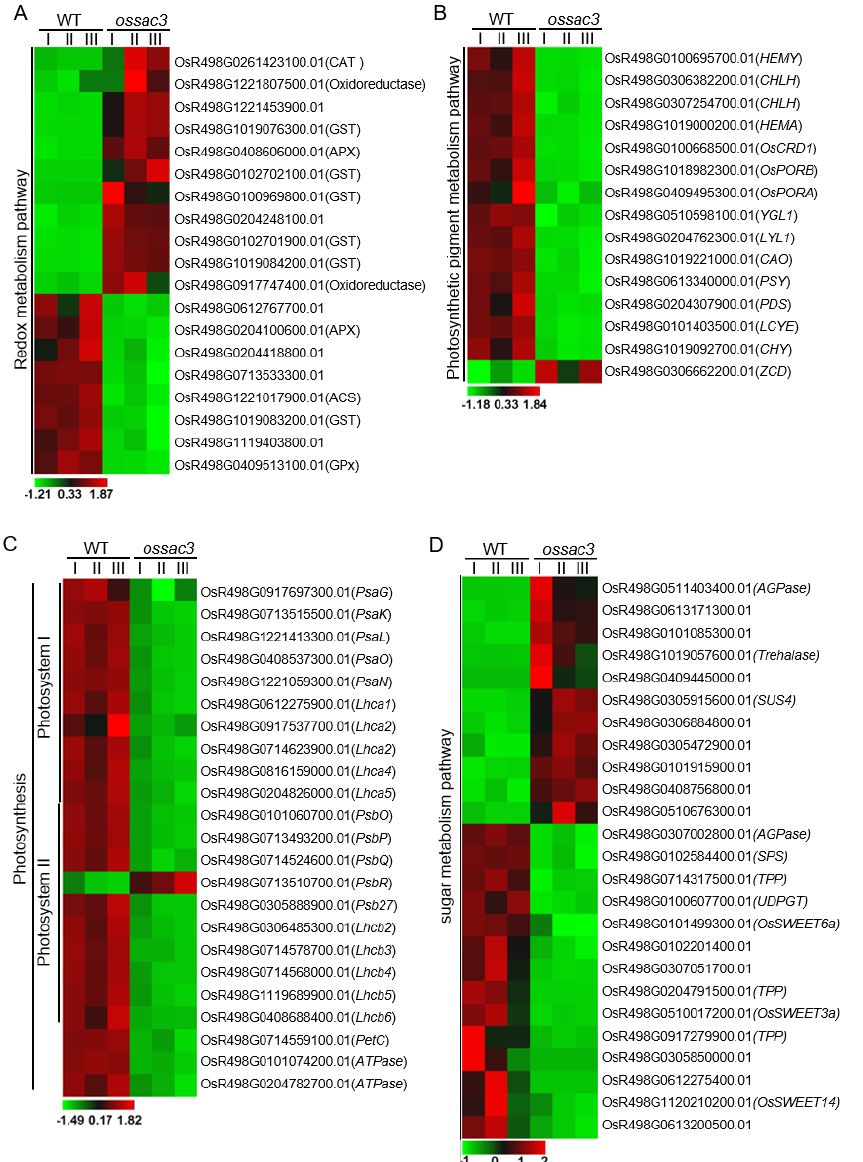
Figure 5. Redox metabolism, photosynsthesis and sugar metabolism were affected in ossac3 . ( A – D ): Heatmap showing the expression patterns of selected genes in the process of redox metabolism ( A ), photosynthetic pigment metabolism ( B ), photosynthesis ( C ) and sugar metabolism ( D ) related process. Data are from three biological replicates (I, II and